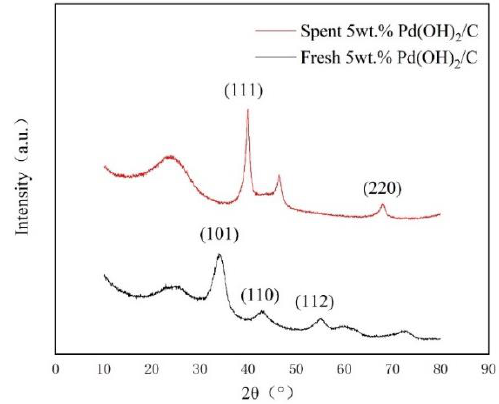
Figure 4. X-ray diffraction patterns of the various catalysts.